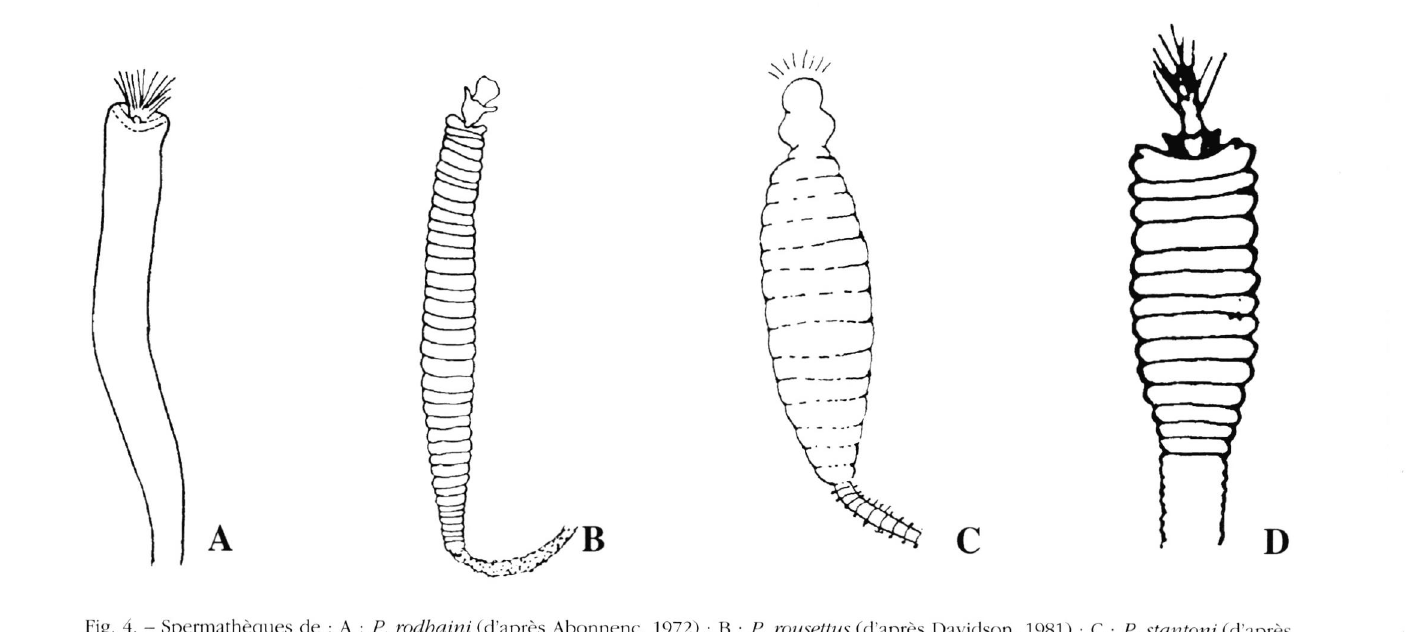
Fig. 4. - Spermathèques de : A ; P. rodhaini (d'après Abonnenc. 1972) ; B : P. rousettus (d'après Davidson, 1981) ; C : P. stantoni (d'après Raynal, 1935) .